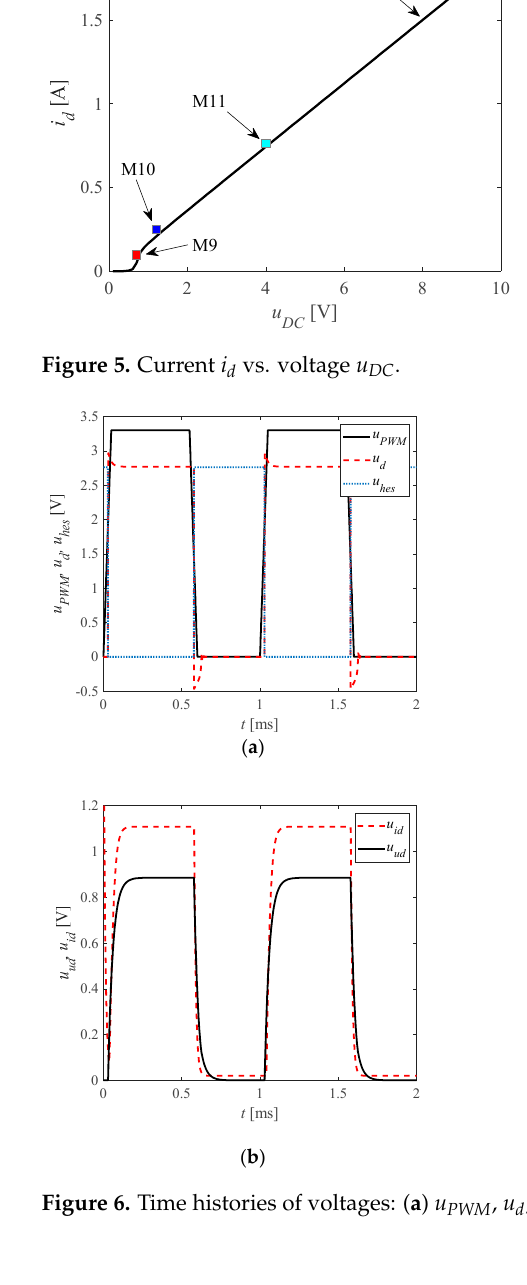
PWM , u d , u hes ; ( b ) u id , u ud